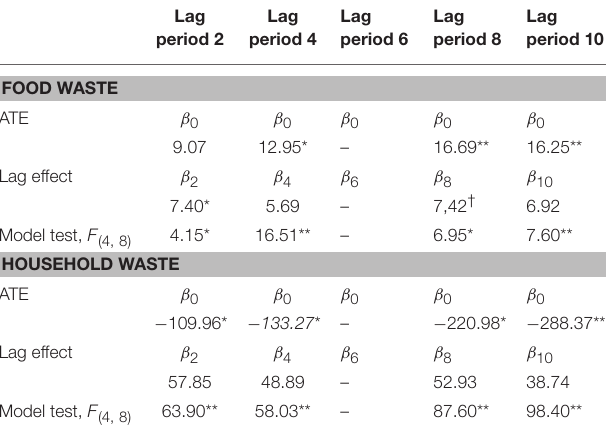
TABLE 3 | Average treatment effects for food waste and household waste through a panel data regression model, robust standard error in brackets.